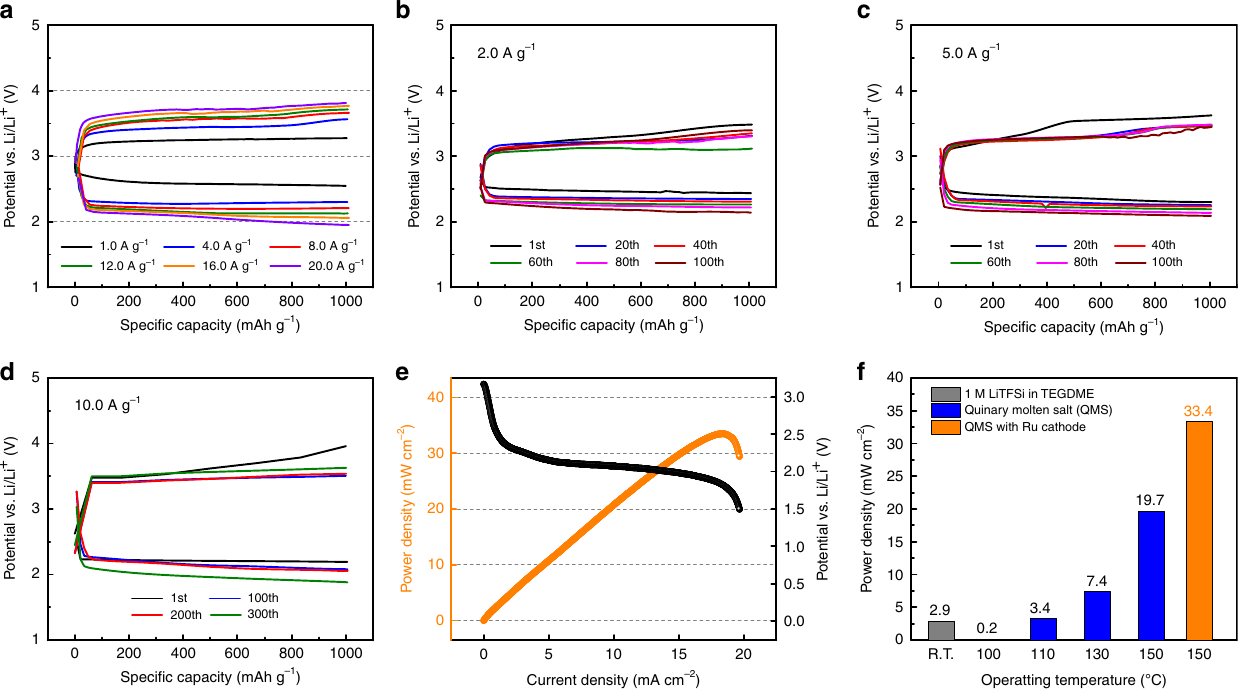
Fig. 6 Electrochemical performance of Li – CO 2 cell by using molten salt and Ru nanoparticle. a Galvanostatic discharge – charge pro fi les of the Li – CO 2 battery with quinary-molten salt electrolyte with a Ru nanoparticle cathode at different current densities from 1.0 to 20.0 A g − 1 at 150 °C. Cycling performance of the Li – CO 2 battery at current rates of 2.0 A g − 1 ( b ), 5.0 A g − 1 ( c ), and 10.0 A g − 1 ( d ). e Polarization and power-density curves of quinary- molten salt electrolyte with the Ru nanoparticle cathode with a scan rate of 0.01 mA s − 1 . f Plots of peak power density of 1 M LiTFSI in TEGDME (gray); quinary-molten salt at 100, 110, 130, and 150 °C (blue); quinary-molten salt electrolyte with a Ru nanoparticle cathode at 150 °C